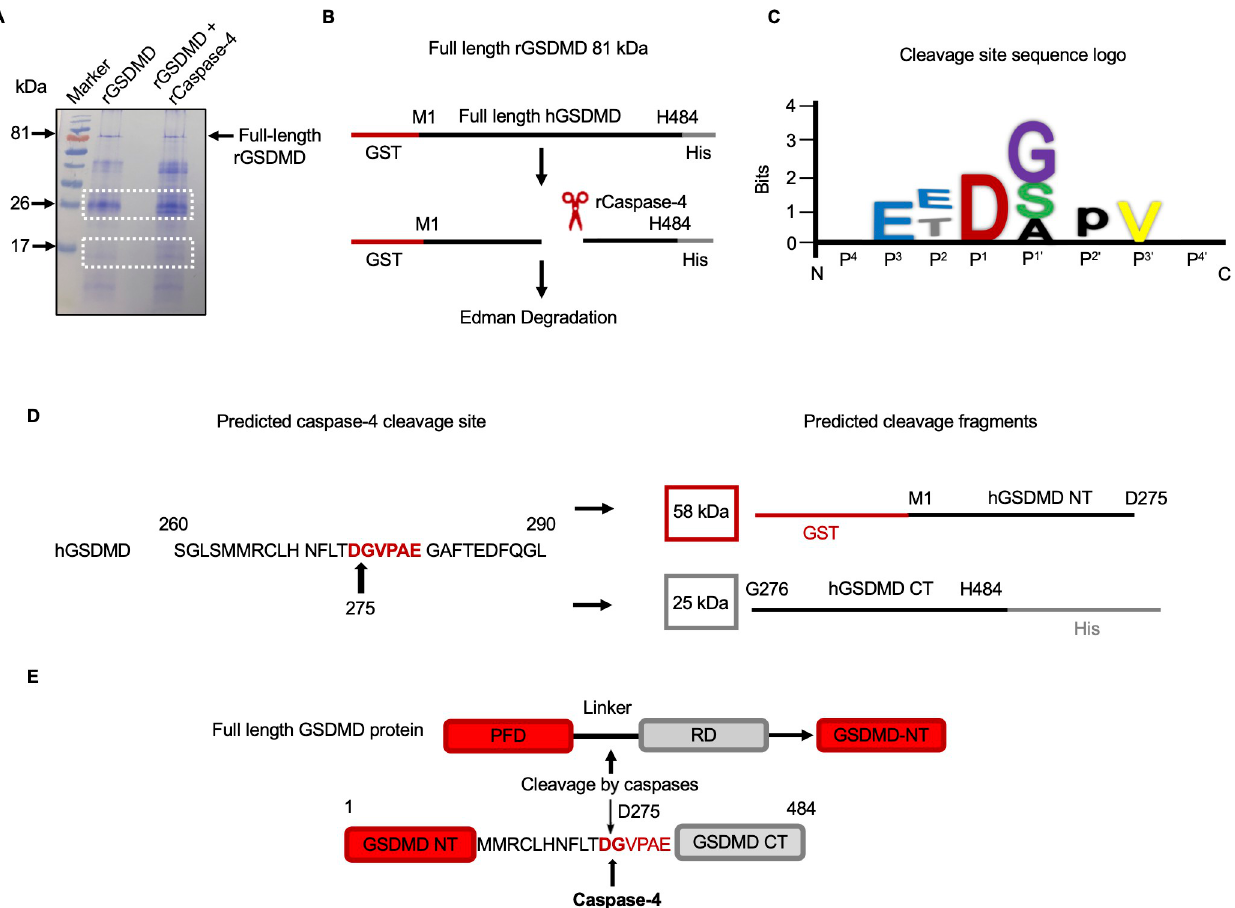
Fig 12. Predicated cleavage site for caspase-4 on GSDMD. The molecular weight of full length rGSDMD is 81 kDa as a GST tag is linked to NT of rGSDMD, whereas CT is tagged by His. ( A ) Cleavage of 5 μ g purified recombinant GSDMD with 6U recombinant caspase-4 visualized by Coomassie blue staining of the protein bands that were excised (white dotted box) and sequenced by Edman degradation. Immunoblot is representative of at least three independent experiments (n = 3). ( B ) Schematic representation showed full length rGSDMD with tags. Red line indicated GST tag attached to the NT, while CT was linked by a His tag in grey, and full GSDMD sequence is marked in black. ( C ) Caspase-4 cleavage sequence logo was generated from “MEROPS” (https://www.ebi.ac.uk/merops/) based on the peptidase database. ( D ) After alignment of the calls that we obtained from Edman degradation, the predicated cleavage for caspase-4 on GSDMD marked the same cleavage site as caspase-1 (black arrow). ( E ) NT GST-tagged rGSDMD incubated with active rC-4 for 16 h at 37˚C and degraded fragments generated from full length GSDMD were evaluated by immunoblot analysis followed by Coomassie blue staining. Edman degradation analysis of the 26 kDa band after alignment of amino acid calls suggested a cleavage site for caspase-4 on GSDMD at aspartic acid 275 (D275)